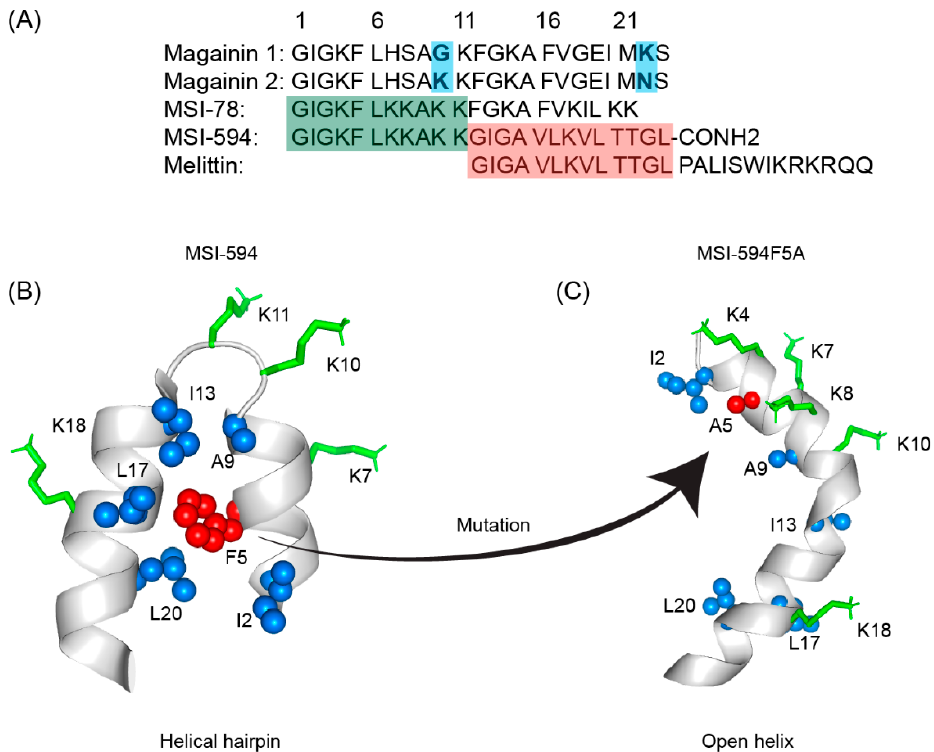
Figure 5. ( A ) Amino acid sequences of magainin 1, magainin 2, MSI-78, MSI-594, and melittin. The sequence of MSI-594 was derived from MSI-78 and melittin, as indicated by the green and maroon boxes, respectively. ( B ) MSI-594 adopted helical hairpin or helix-loop-helix structure in presence of LPS, while ( C ) mutation of Phe5Ala converted the helical hairpin structure to open helix conformation in the same environment [121,122] .